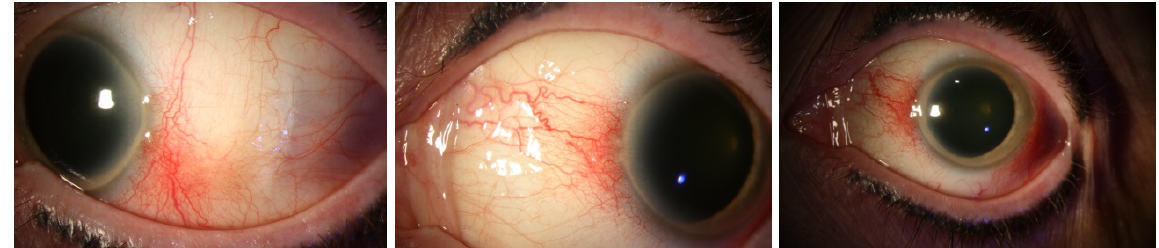
Figure 1: The anterior segment of both eyes revealed a nasally and temporally sectoral conjunctival injection with a nodule suggestive of nodular anterior scleritis.